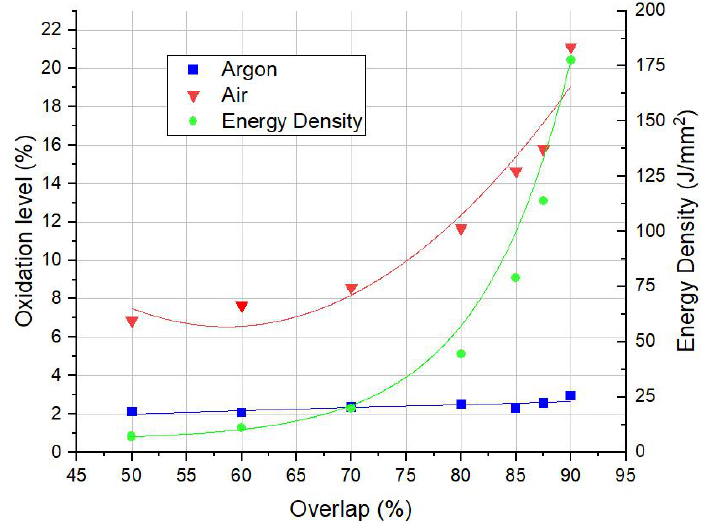
Figure 4. Surface oxidation level of the samples produced in accordance with Table 2 and the Laser Energy Densities values used in the experiment.